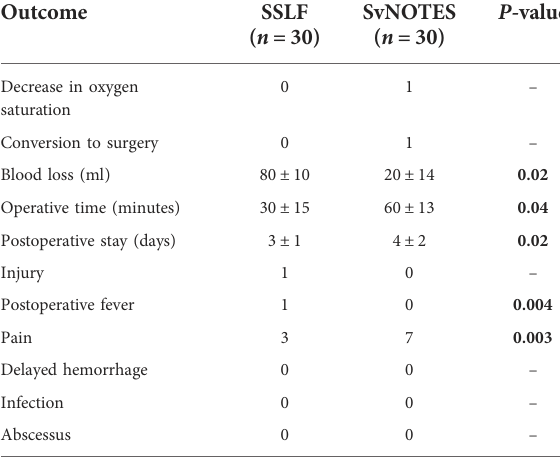
TABLE 2 Perioperative outcomes by the surgical group. a Outcome Decrease in oxygen saturation